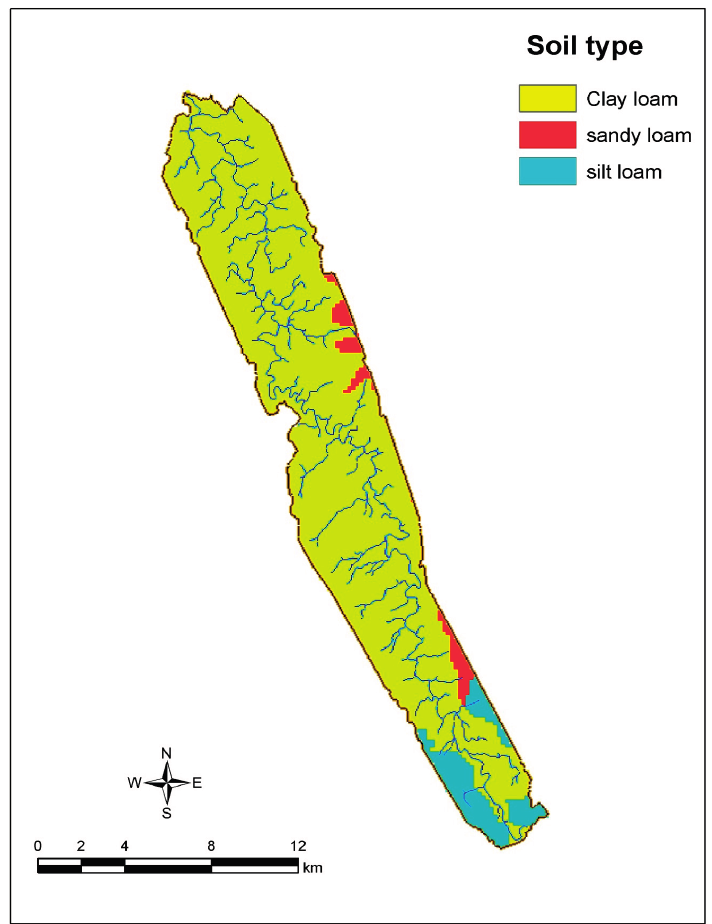
Figure 3. Soil type index map of the study